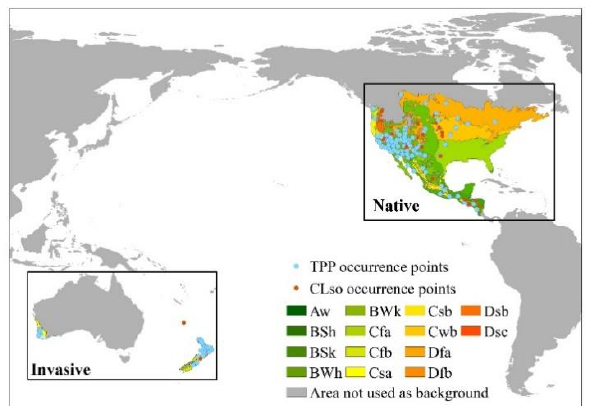
Figure 1. Occurrence points and delimited background for native and invasive populations of tomato potato psyllid (TPP) and Candidatus Liberibacter solanacearum (CLso). Colors refer to the Koppen climate zones, and gray represents non-target background. Letter codes refer to climate classification: A , equatorial; B , arid; C , warm temperate; D , snow; W , desert; S , steppe; a , hot summer; b , warm summer; c , cool summer; f , fully humid; h , hot arid; s , summer dry; w , winter dry.